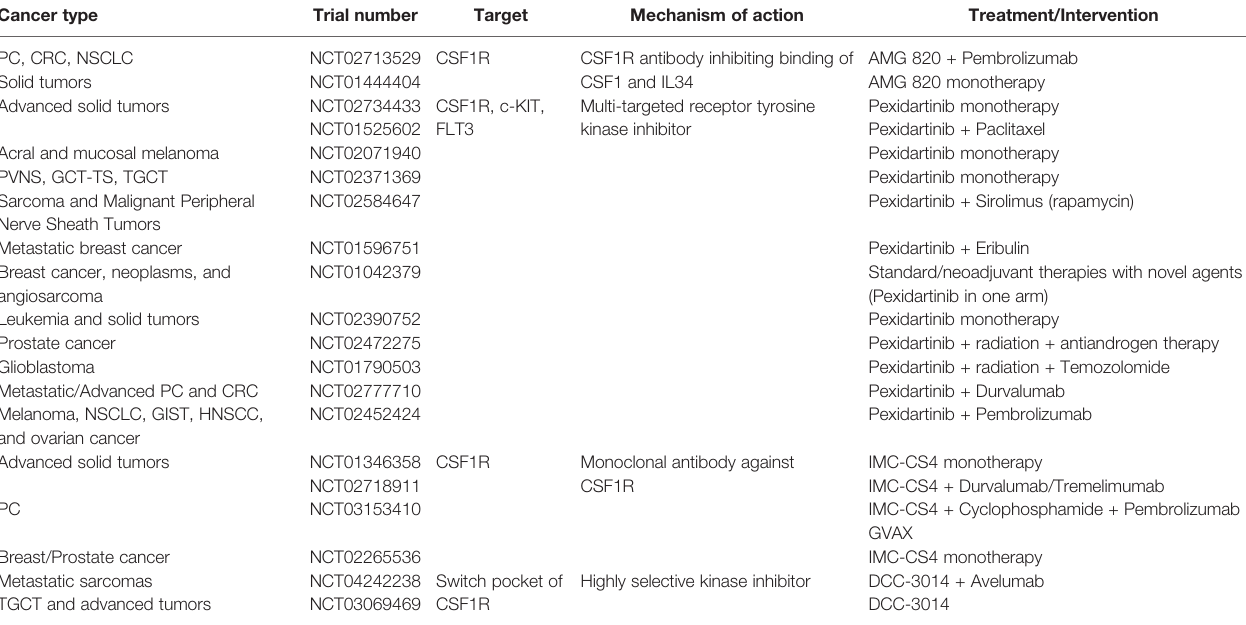
TABLE 4 | Clinical trials targeting TAM through CSF-1 inhibition.